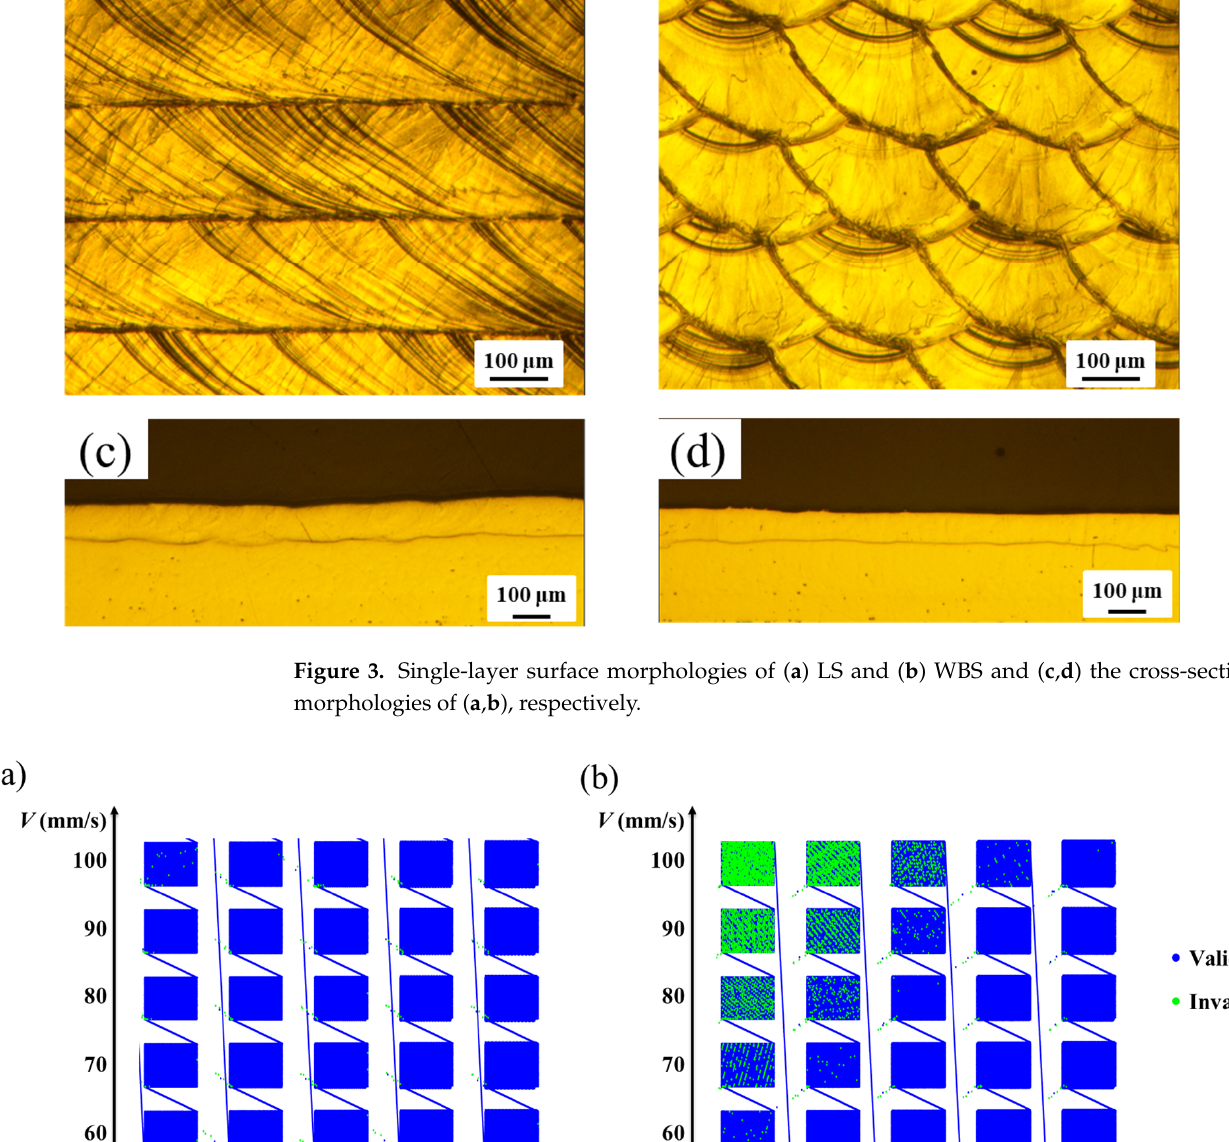
Figure 3. Single-layer surface morphologies of ( a ) LS and ( b ) WBS and ( c , d ) the cross-sectional morphologies of ( a , b ), respectively.